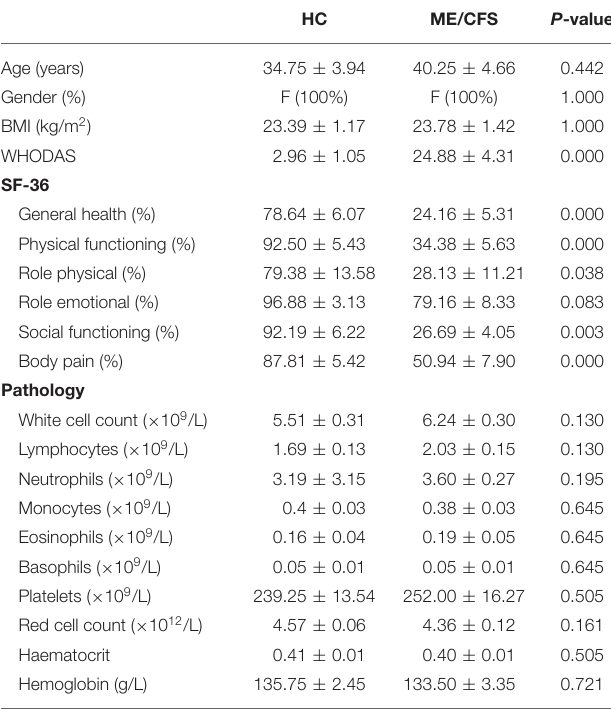
TABLE 1 | Blood parameters and patient